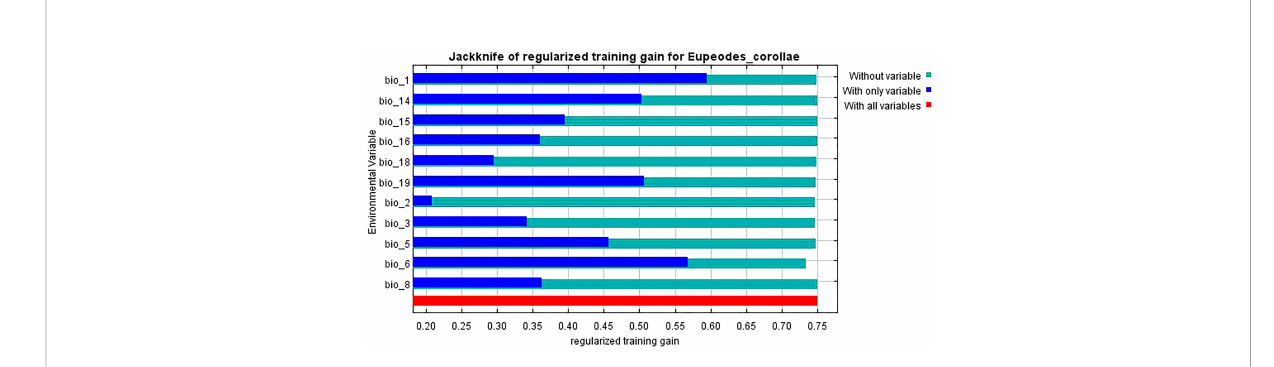
FIGURE 6 Evaluation of environmental variables affecting the distribution of E. corollae by Jackknife test.